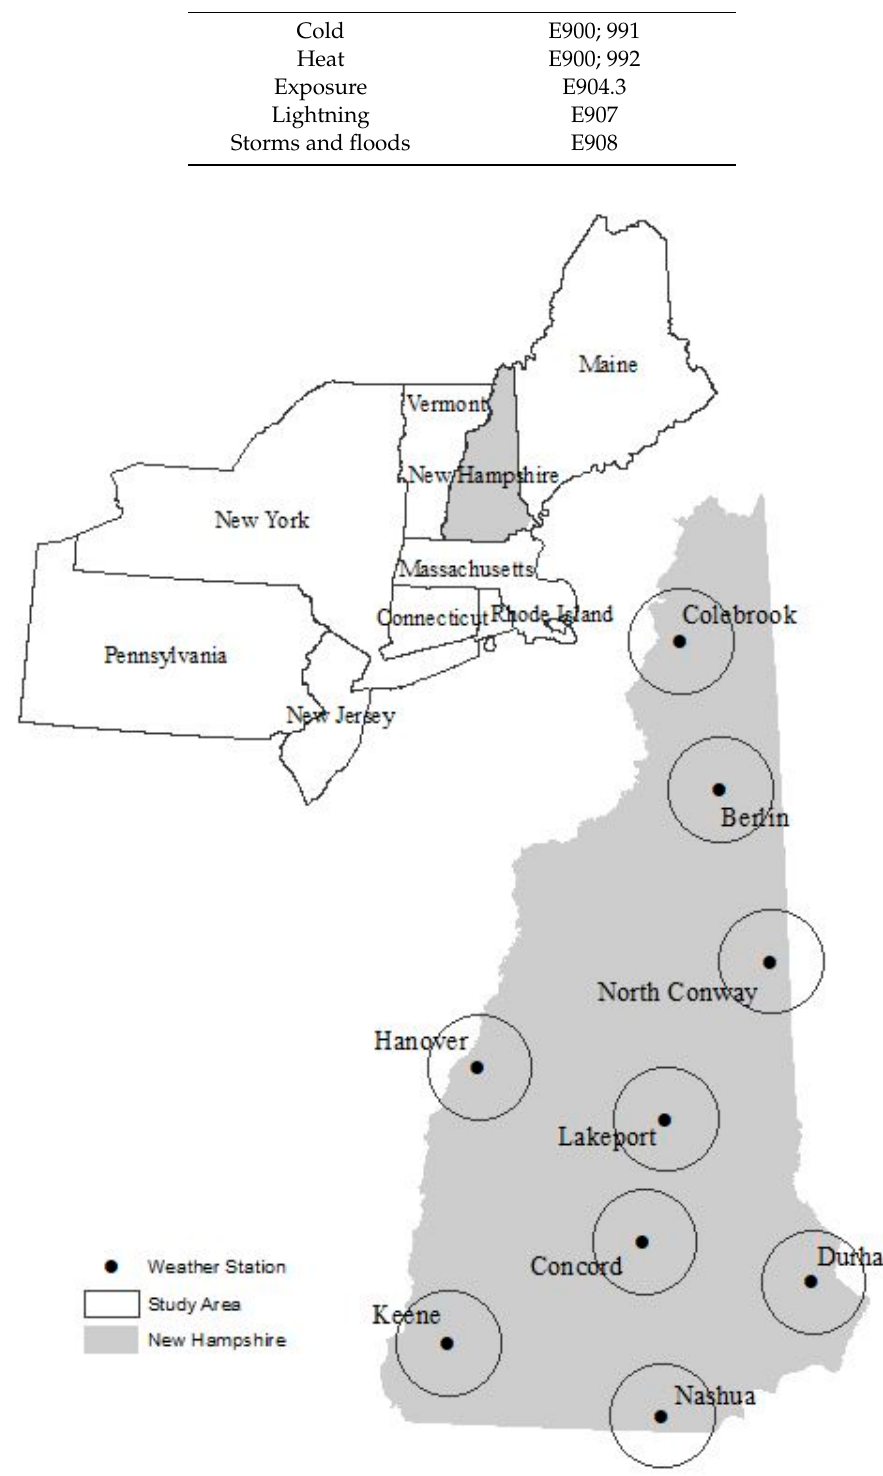
Figure 1. Study areas include all towns within a 10-mile buffer of the weather stations.